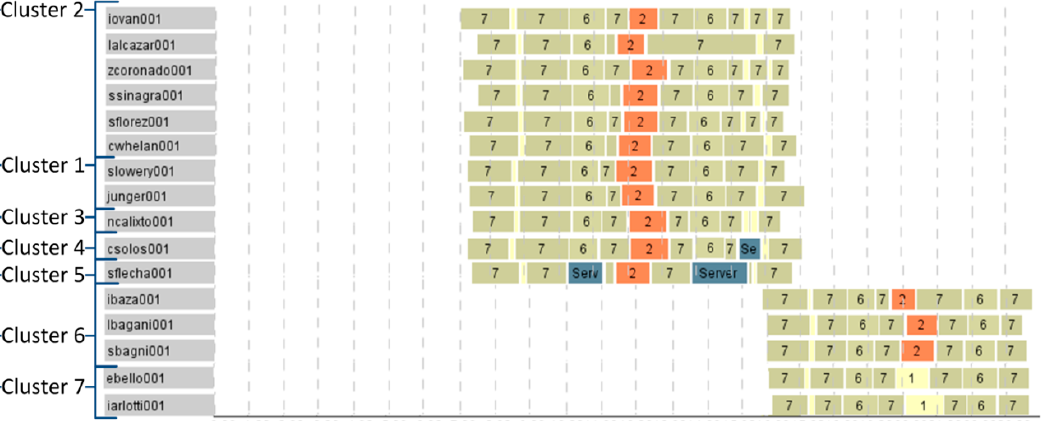
Figure 5. The graphical representation of the employees’ routes using the BandView model.